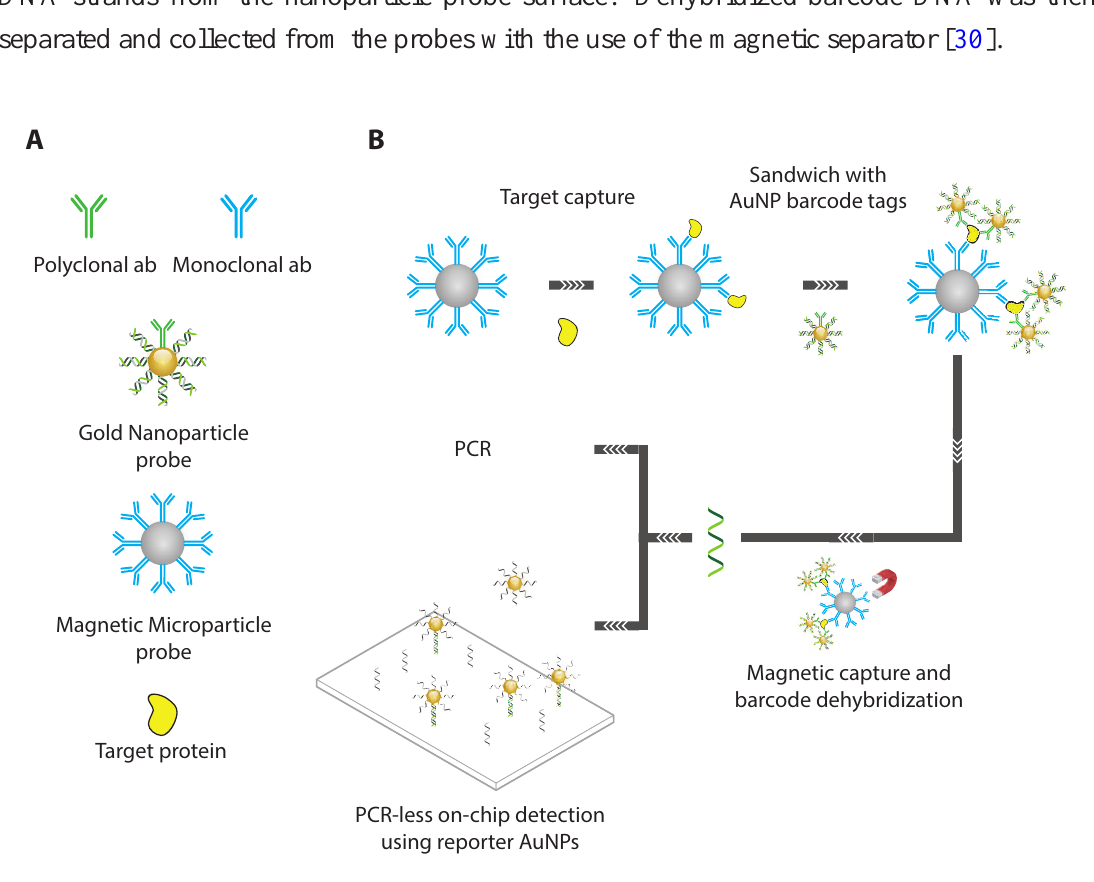
Figure 8. Overview of the bio-barcode assay. (A) For a specific target, mAb-functionalized MMPs are prepared, along with pAb functionalized DNA-AuNP conjugates. (B) In a